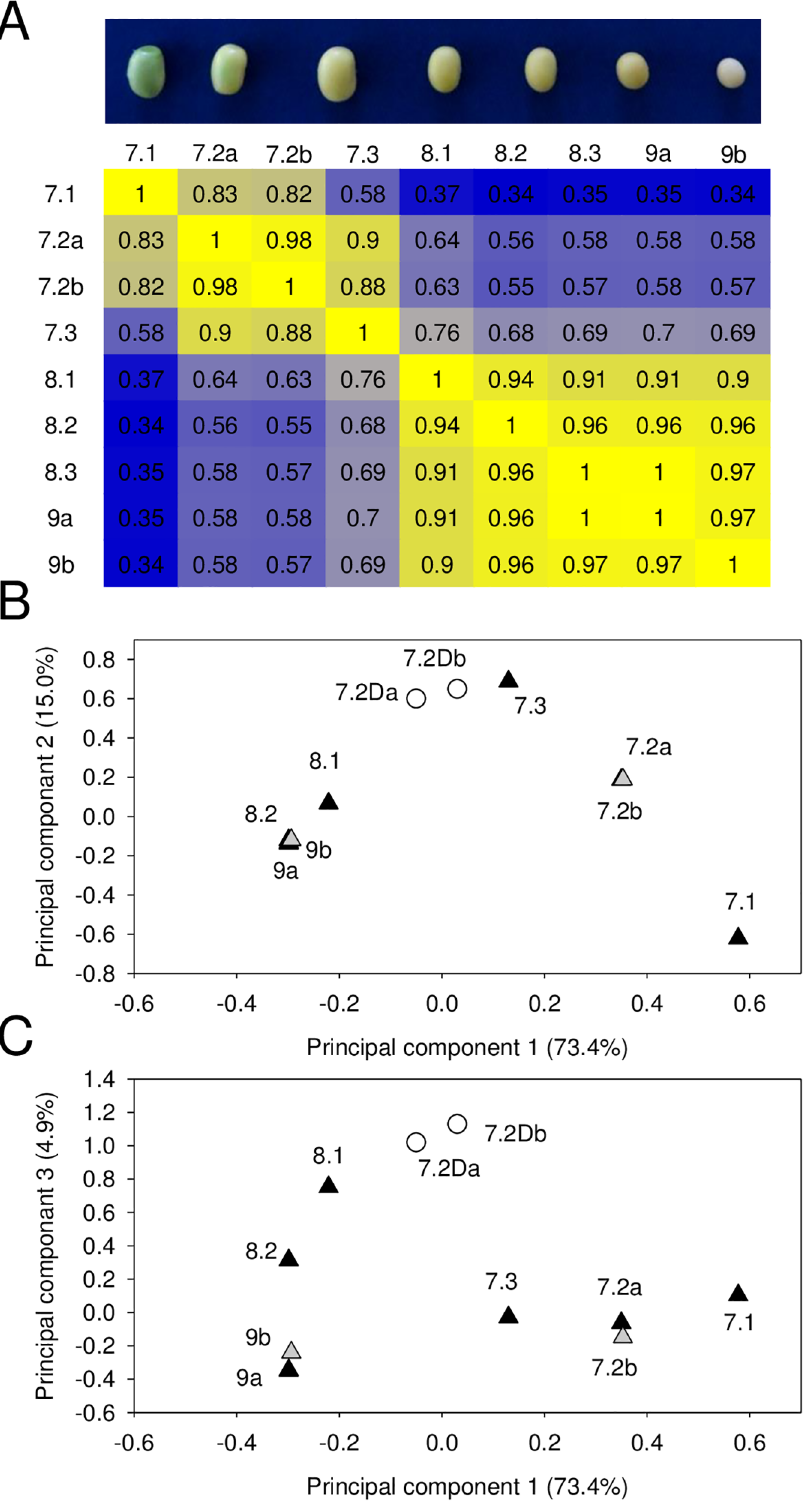
PLOS ONE | https://doi.org/10.1371/journal.pone.0180282 July 12,